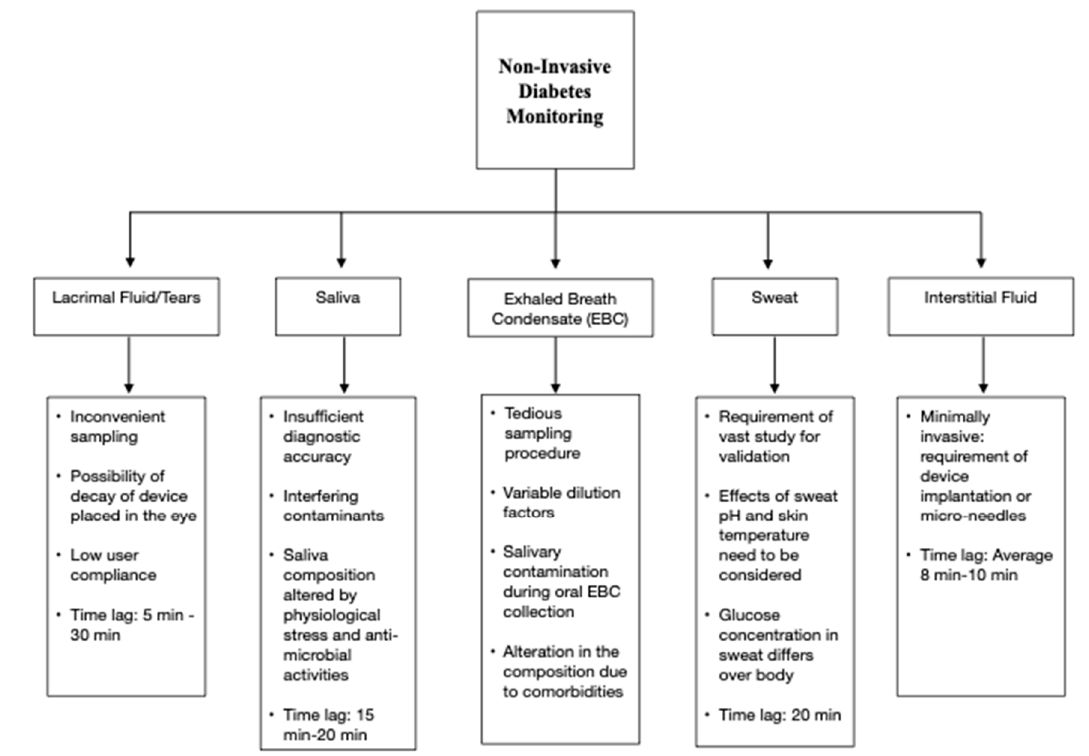
Figure 1. Non-invasive diabetes monitoring using biofluids. Table 1. Glucose-monitoring devices working on non-invasive/minimally invasive technologies.